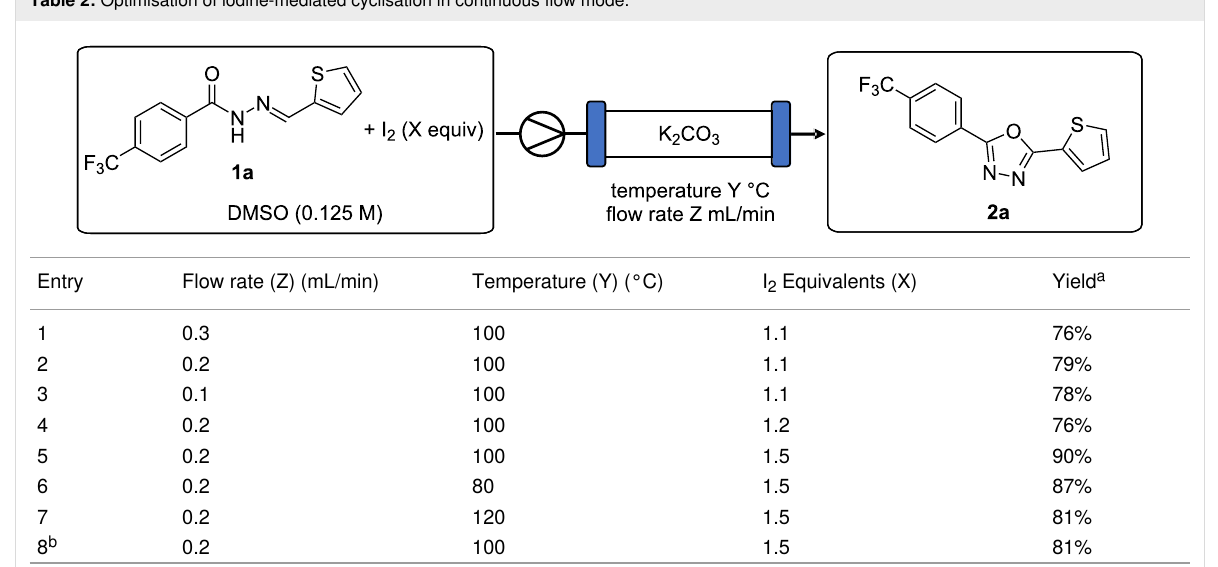
Table 2: Optimisation of iodine-mediated cyclisation in continuous flow